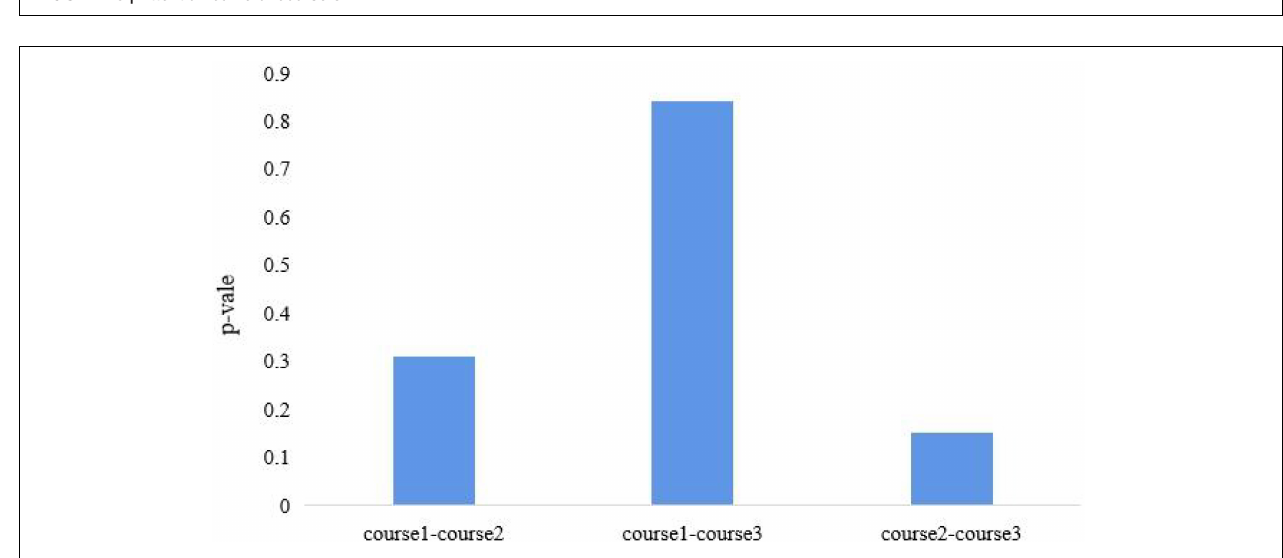
FIGURE 14 | P -value of